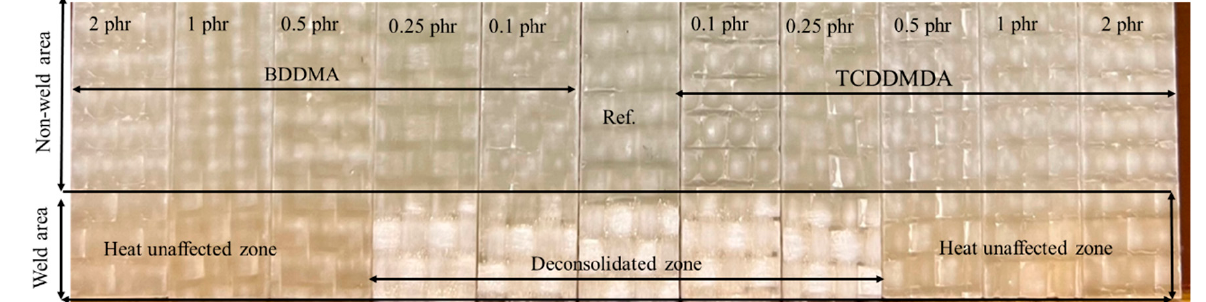
Figure 6. The deconsolidated area during heating the composites for IR welding. Ref. stands for the Elium ® matrix without multifunctional methacrylate monomers.